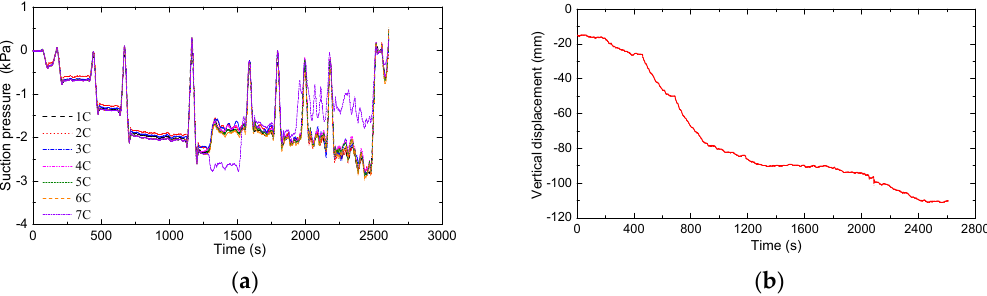
Figure 8. Variations in suction and displacement with time in PS2-1. ( a ) Relationship between suction and time; ( b ) Relationship between displacement and time.